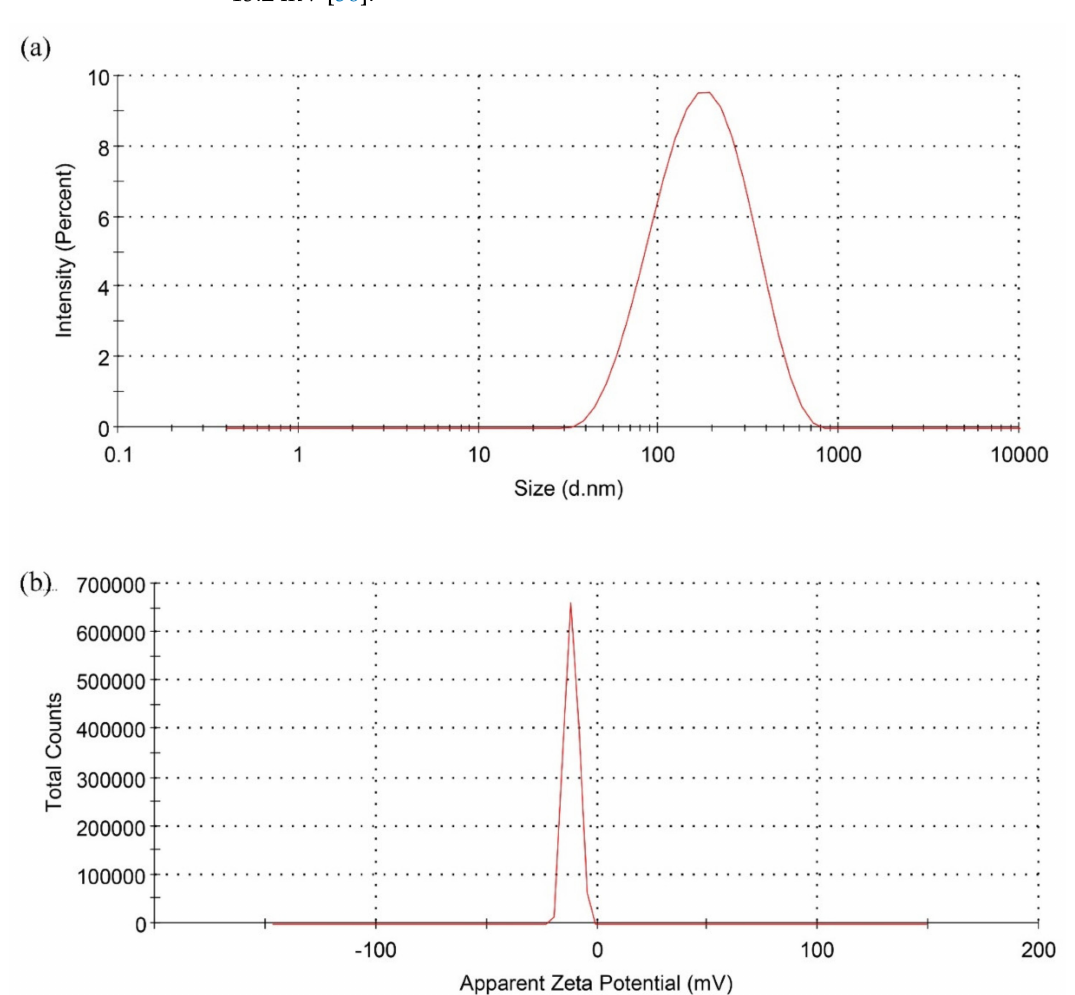
Figure 5. Characterization of TiO 2 NPs by photon correlation spectroscopy. ( a ) Particle size distribu- tion. ( b ) Apparent zeta